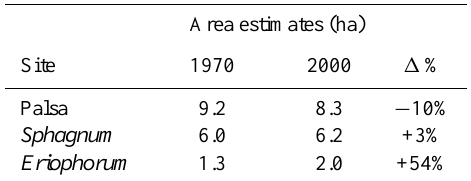
Table 4. Area estimates of vegetation type distribution at the mire (from Johansson et al., 2006b 1 )